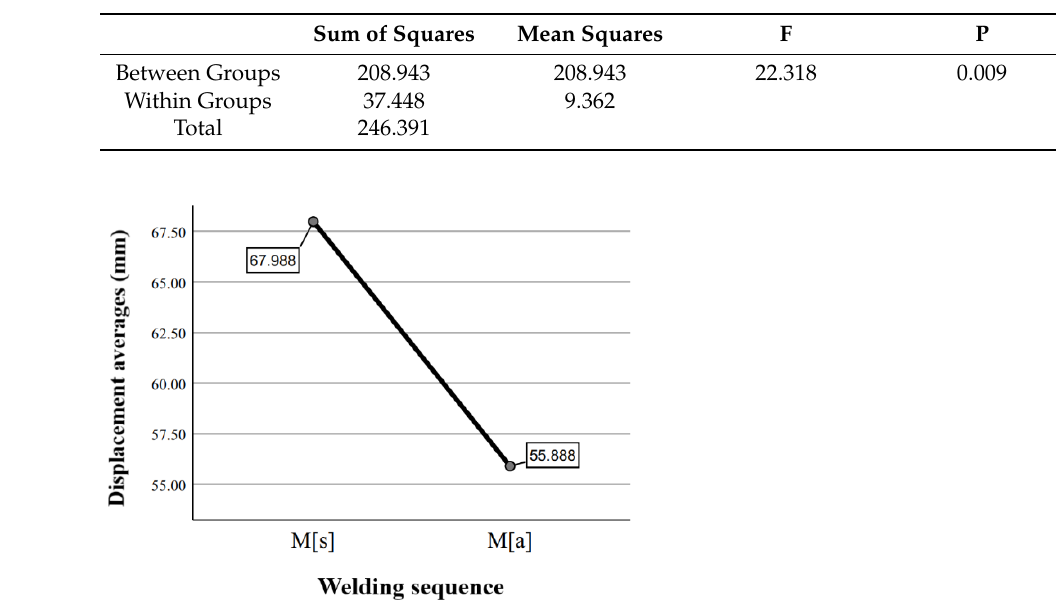
Table 4. ANOVA analysis between the orientation and direction of multipass welding.